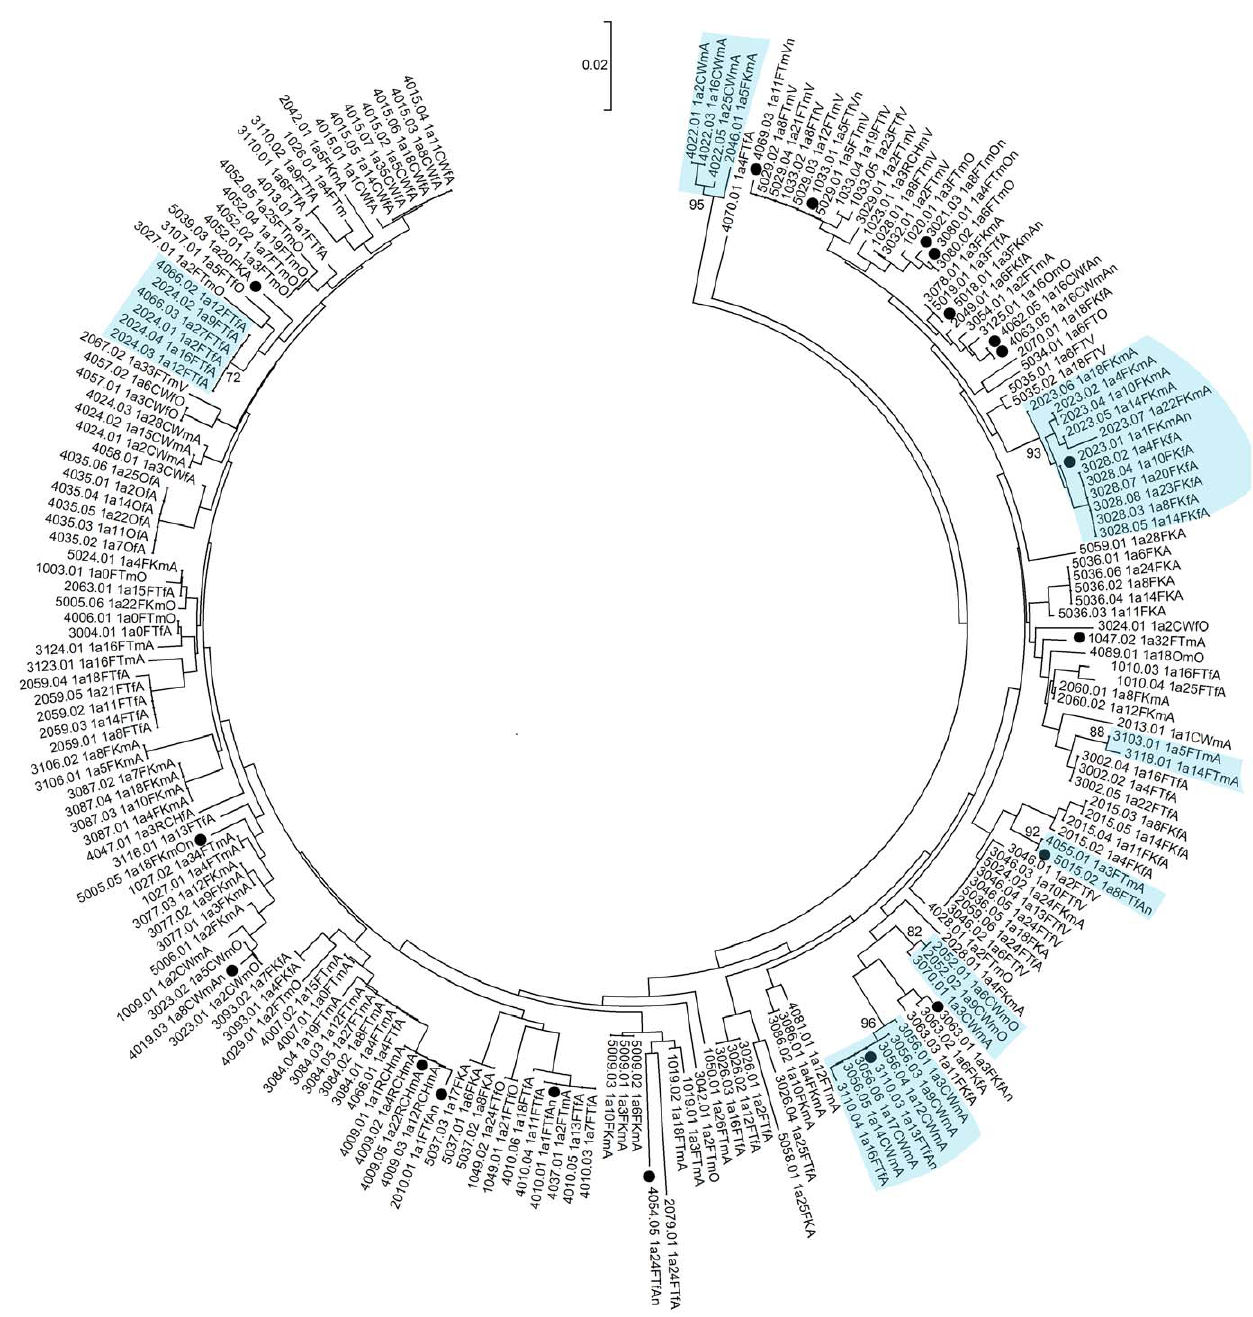
Figure 3. Neighbor-joining analysis of HCV genotype 1a core sequences. Phylogenetic clusters defined by bootstrap analysis (cut-off 70%) with infections from multiple individuals in the study are highlighted in blue and bootstrap values for these clusters are indicated. Newly acquired infections and changes in viral sequence are denoted using black-filled circles.